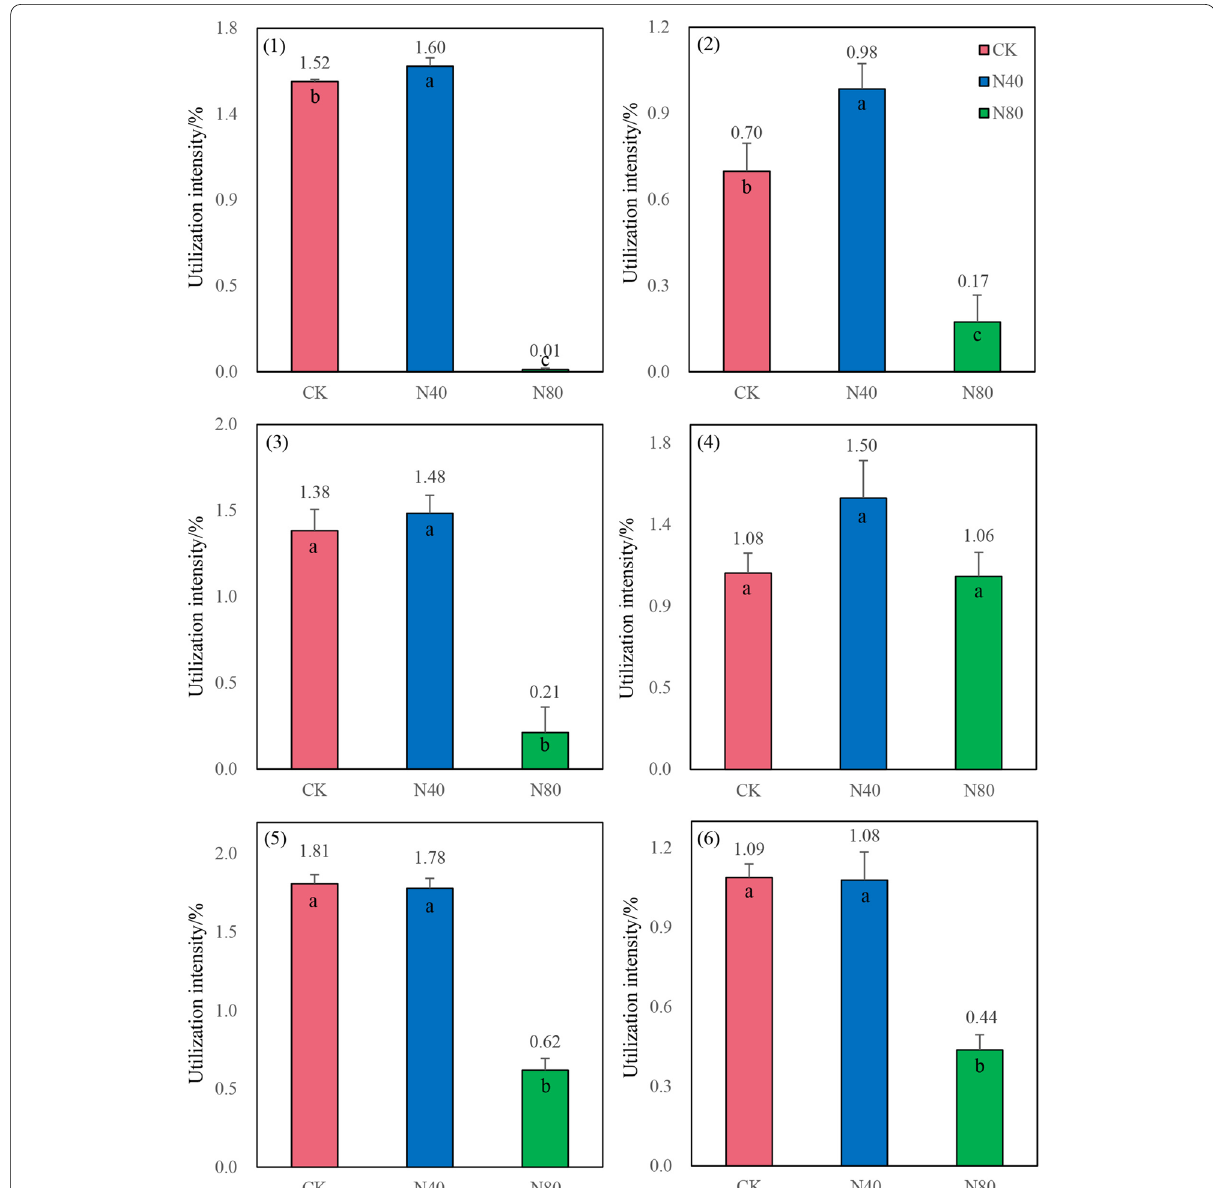
Fig. 2 Utilization of different carbon sources by soil microbial communities under different nitrogen addition concentrations. 1 Carbohydrate, 2 amino acids, 3 alcohols, 4 esters, 5 amine, 6 acids; lowercase letters indicate significant differences ( P < 0.05). CK, control; N40, 40 kg N ha − 1 a − 1 ;